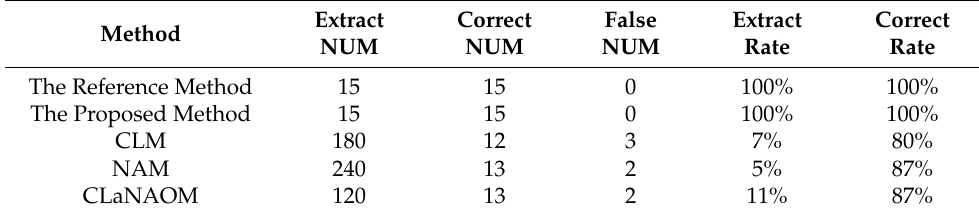
Table 22. The mountain vertices extraction results for each method using the seventh dataset.